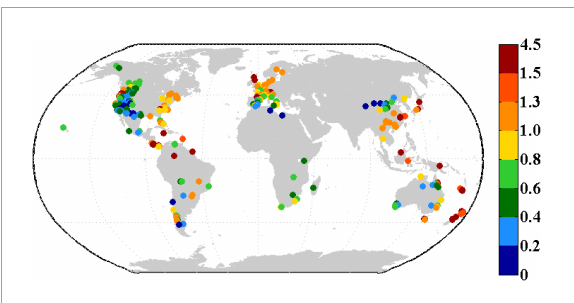
FIGURE1 Distribution of the study sites ( n = 370) and their corresponding AI